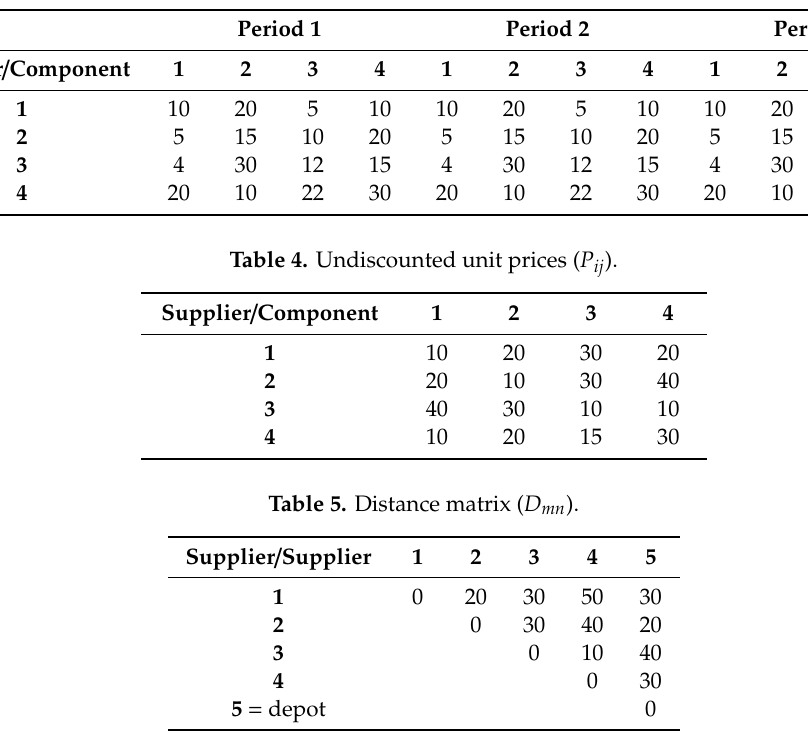
Table 3. Supplier capacities ( s ijt ).